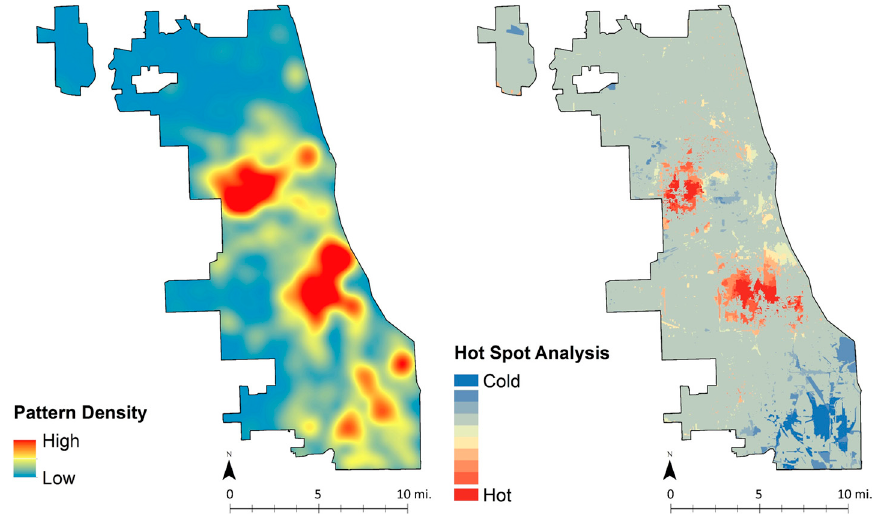
Figure 7. Vacant land pattern density map ( left ) and hot-spot analysis showing statistically significant clusters of vacant land ( right ) in Chicago, IL.